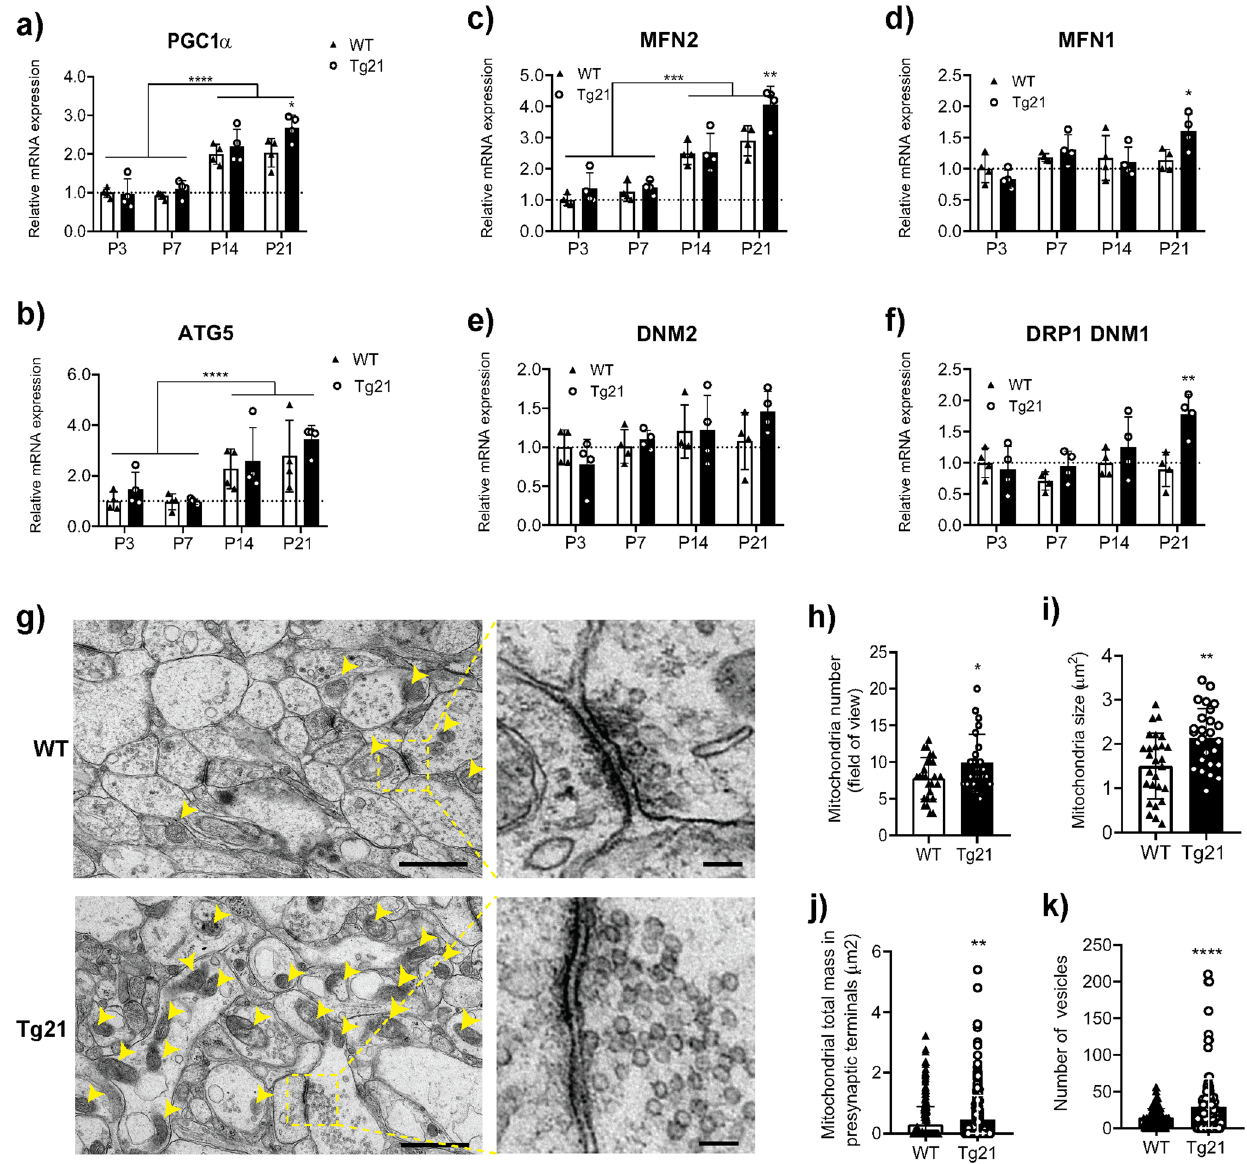
Fig. 6 EPO overexpression in CNS upregulates PGC1-1 α , alters control of mitochondria dynamics, increases mitochondria size, increases mitochondria number, and increases the number of vesicles in presynaptic terminals of the hippocampus. a PGC-1 α mRNA expression in hippocampus from WT and Tg21 mice. PGC1 α increases with age in both genotypes; 2-way ANOVA, F (3,24) = 46.93, **** p < 0.0001. At P21, a higher expression is observed in Tg21 mice; LSD post hoc, * p = 0.03. b ATG5 mRNA expression in hippocampus from WT and Tg21 mice. ATG5 demonstrates age-dependent increases with no difference between genotypes; 2-way ANOVA, F (3,24) = 11.98, **** p = 0.0001. mRNA expression of pro-fusion: c Mitofusin 2 ( MFN2 ) and d mitofusin 1 ( MFN1 ), and of pro- fi ssion: e dynamin 2 ( DNM2 ), and f dynamin-related protein 1-dynamin 1 ( DRP1-DNM1 ) in WT and Tg21 hippocampus. Transcriptional control of fusion (both MFN1 and MFN2 ) is enhanced in Tg21 mice at P21; 2-way ANOVA: MFN1 , F (1,24) = 1,143, * p = 0.30; and MFN2 , F (1,24) = 7.216, ** p = 0.01. An age-dependent increase in MFN2 is observed in both genotypes; 2-way ANOVA, F (3,24) = 48.59, *** p < 0.001. Pro- fi ssion DNM2 shows no change in expression across development nor between genotypes; 2-way ANOVA, F (1,24) = 0.37, p = 0.54. Pro- fi ssion DRP1-DNM1 is higher in Tg21 at P21; 2-way ANOVA, F (1,24) = 8.834, ** p = 0.007. p . a – f Relative mRNA expression levels of the aforementioned genes are quanti fi ed by qPCR and normalized to ACTB . g Representative electron microscope (EM) images of hippocampal CA1 area from WT and Tg21 mice at P14. More mitochondrial pro fi les (yellow arrows) and a higher number of vesicles in presynaptic axon terminals are observed in Tg21 mice. Scale bar: 1 μ m (right panels) and 100 nm (panel insets). h Quanti fi cation of mitochondria number in the total fi eld of view; unpaired t -test, * p = 0.036. i Mitochondria size; unpaired t -test, p = 0.002. j Mitochondria total mass in presynaptic terminals; unpaired t -test, ** p = 0.0043. k Vesicle numbers in presynaptic terminals; unpaired t -test, **** p < 0001. Barplots with SD